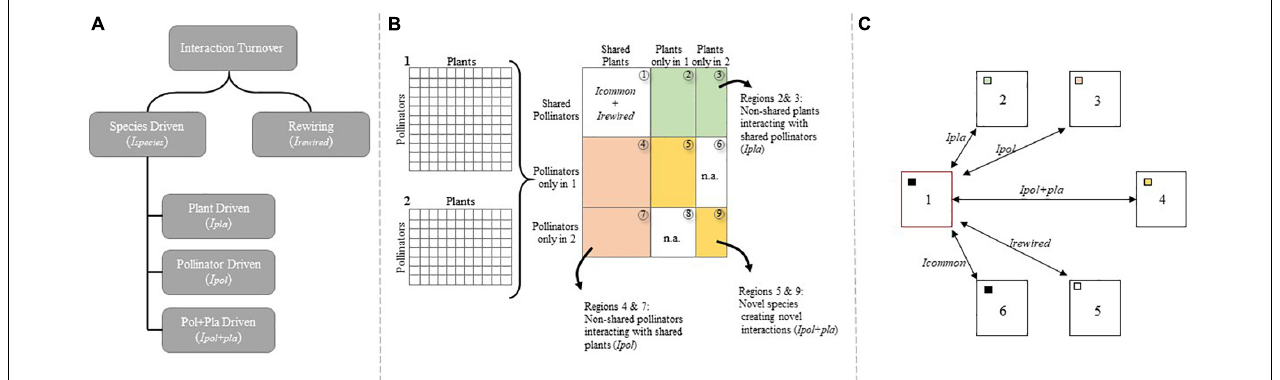
FIGURE 2 | (A) Interaction turnover between two ecological networks can be partitioned into contributions from rewiring (i.e., when shared species alter their interactions; I rewired ) and species-driven turnover (i.e., when changing species composition change interactions; I species ), with the latter being further partitioned into pollinator-driven ( I pol ), plant-driven ( I pla ) and pollinator + plant-driven ( I pol + pla ) interaction turnover. (B) Matrices 1 and 2 represent ecological networks, with pollinator species arranged in rows and plant species in columns, which are artificially merged into one large matrix in order to identify interactions contributing to the different categories of interaction turnover. Region 1 contains interactions between shared species, and I common denotes interactions found in both 1 and 2 , whereas I rewired is the sum of interactions only observed in either matrix 1 or 2, but between shared species. Shaded areas contain interactions contributing to species–driven interaction turnover. Interactions located in regions 2 and 3 are between shared pollinators and non-shared plants (i.e., the plants are found in either matrix 1 or 2 but not both) and represent plant–driven interaction turnover. Interactions located in regions 4 and 7 are between shared plants and non-shared pollinators comprising the pollinator-driven interaction turnover. Finally, regions 5 and 9 contain interactions between non-shared pollinators and non-shared plants and comprise the pollinator + plant–driven interaction turnover. Regions marked with n.a. do not contain any interactions due to the artificial merging of matrices 1 and 2. (C) Interaction specific site-pair combinations. This (hypothetical) interaction is observed at sites 1 and 6 (filled squares) while the species pair is also present at site 5, however, without interacting (open square). The plant species is absent from site 2 (green square), the pollinator species absent from site 3 (red square) and both species absent from site 4 (yellow square) allowing a dataset to be created to document all the ways in which interaction networks differ. Six site-pair combinations are possible in this case; 1 ↔ 5 rewiring, 1 ↔ 2: plant driven interaction turnover, 1 ↔ 3 pollinator driven interaction turnover, 1 ↔ 4 plant and pollinator driven interaction turnover and 1 ↔ 6: no interaction turnover (interaction constancy). Figure adapted from Trøjelsgaard et al.